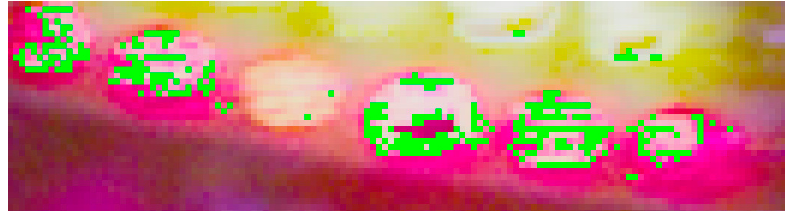
Figure 6. Top 0.1% pixels having the biggest quality difference between the proposed and the fast luma control schemes. The green pixels attributed most to the tPSNR-Y difference between the two luma control schemes.